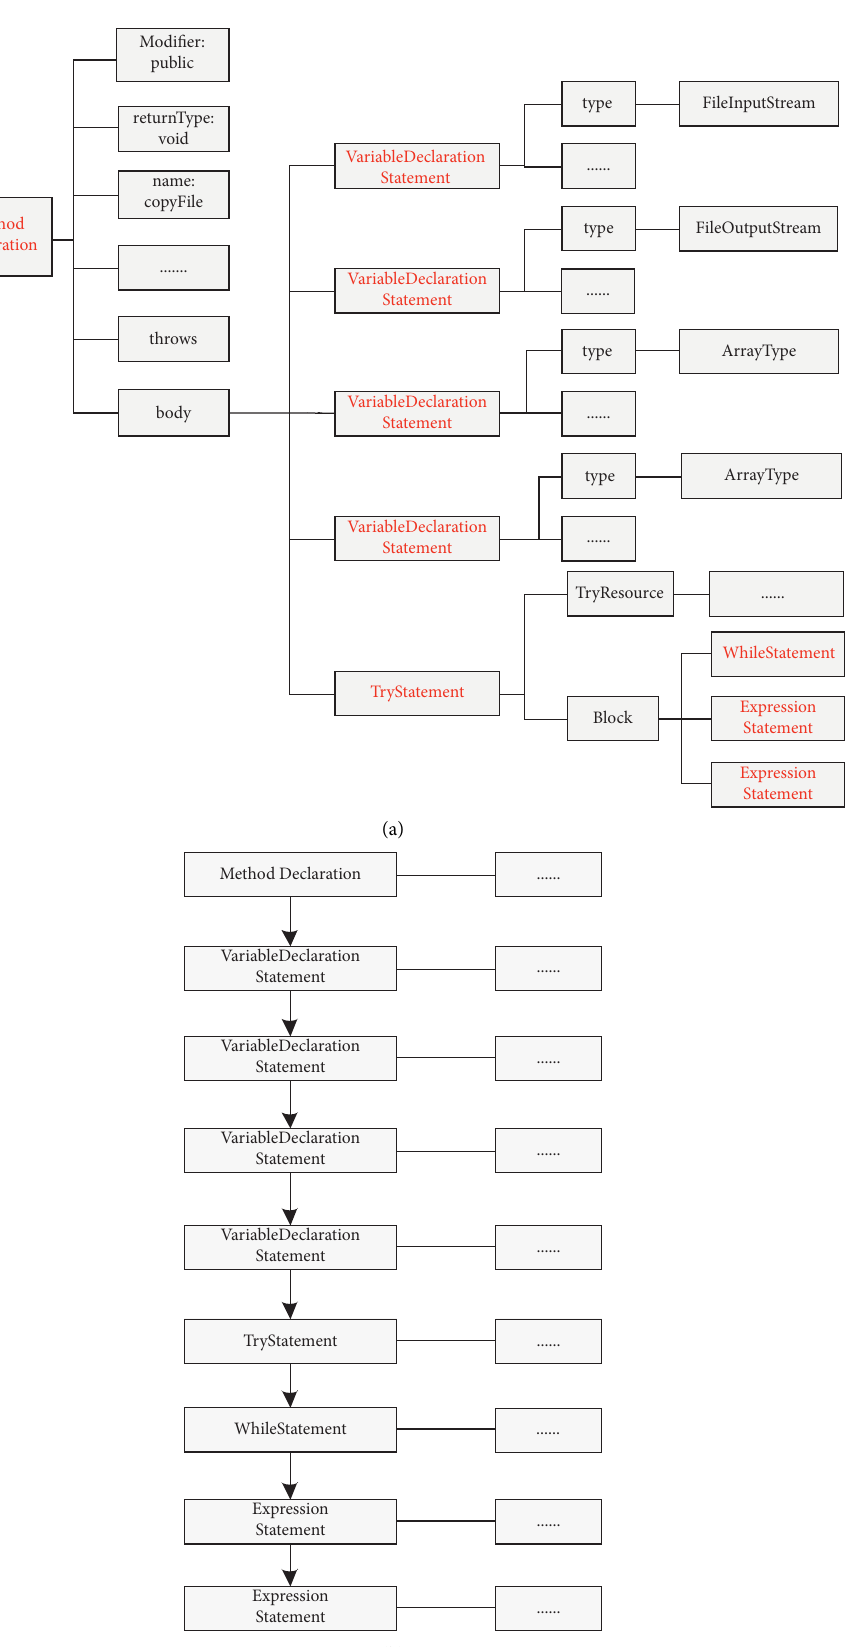
Figure 4: The decomposition of an AST. (a) AST and statement trees. (b) Statement